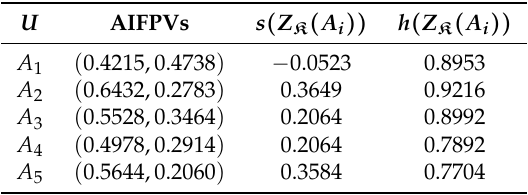
Table 6. AIFPVs and related measures in Case 2.